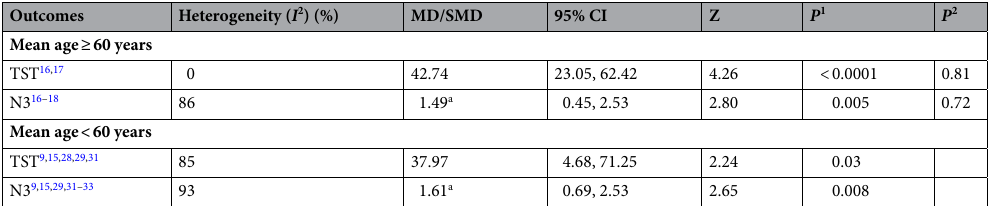
Table 3. Subgroups based on the mean age of participants. CI confidence interval, MD mean differences, N3 non-rapid eye movement stage 3, P 1 variation within the group, P 2 differences between subgroups, SMD standardized mean differences, TST total sleep time. a